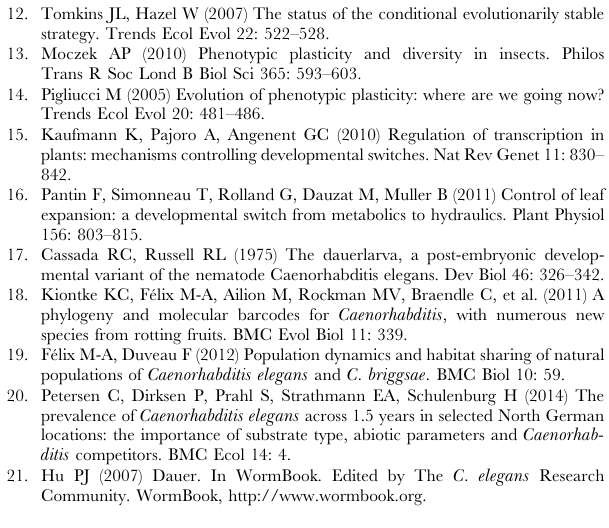
Table S4 Comparisons of dauer larvae formation in response to defined amounts of pheromone between introgression lines with overlapping regions of the CB4856 genome on chromosome I . Shown are the ILs tested, the numbers of dauer larvae, the number of non-dauer larvae (L4s), the total number of worms, and the results of post-hoc comparisons between IL by Fisher’s LSD. Significant comparisons are noted and ‘effect of CB allele’ indicates if the CB4856 genotype at the QTL increases (P) or decreases (N) the number of dauer larvae in comparison to N2. The QTL ‘limits’ columns denote the maximum possible QTL region defined by these comparisons. File S1 Raw data. File A: Data for Table 1, retest of population size and dauer larvae number at food exhaustion of introgression lines at 20% w/v food. File B: Data for Figure 1, population size and dauer larvae number at food exhaustion of introgression lines at differing food concentrations. File C: Data for Figure 2, dauer larvae number a week after food exhaustion. File D: Data for Figure 3, population size and dauer larvae number at food exhaustion of nath-10 lines. File E: Data for Figure 4, the likelihood of dauer larvae formation in the introgression lines. File F: Data for Figure 5, retest of likelihood of dauer larvae formation in chromosome I introgression lines and nath-10